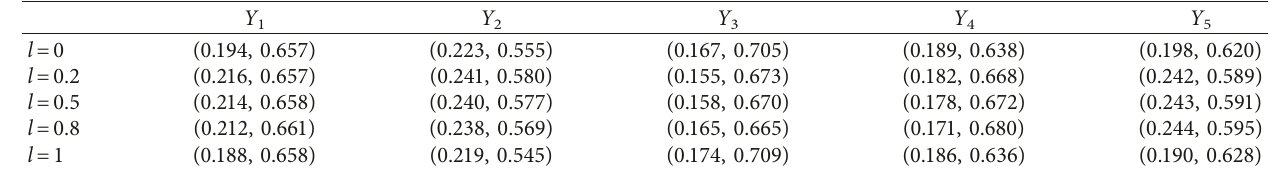
Table 4: Comprehensive values for dynamic ATS-GWIFBM operator.